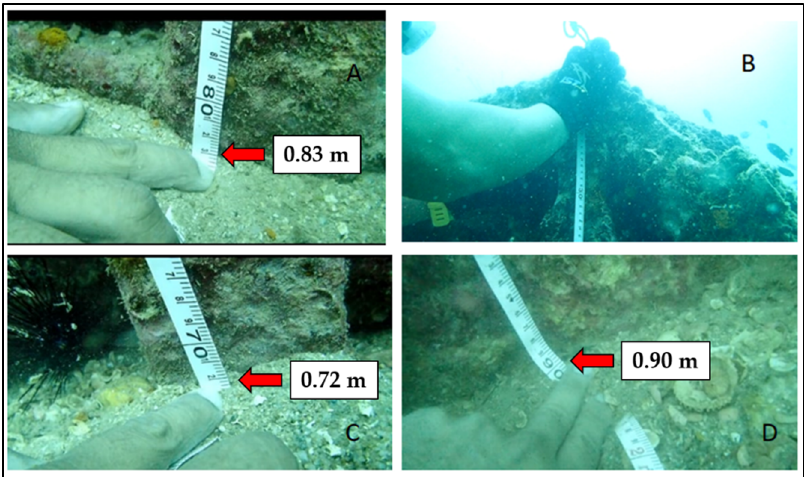
Figure 5. Underwater images showed the measurements taken for a BK AR module at different angles ( A – D ). It shows that there are slight variations across the angle, and that the differences are less than 0.1m.